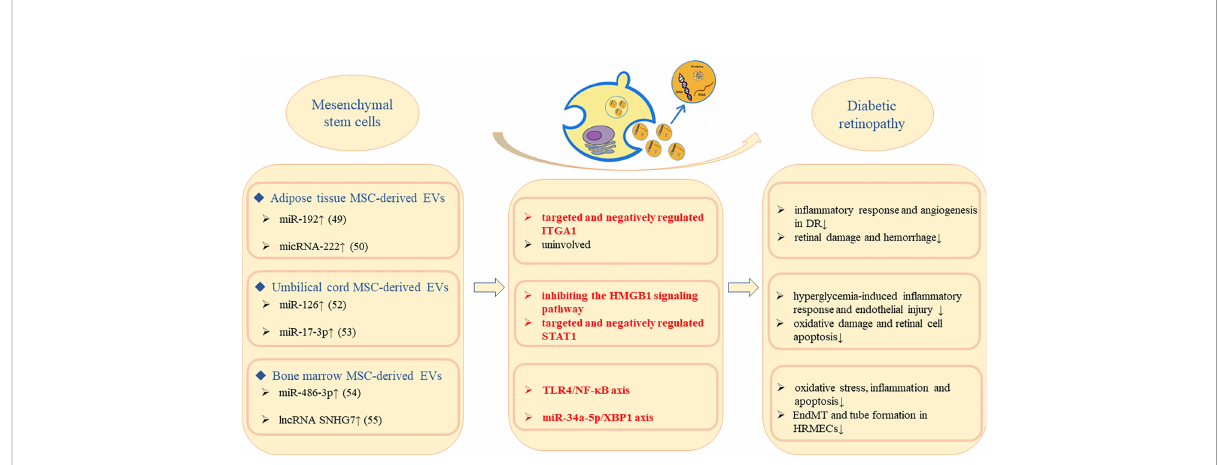
FIGURE 2 Molecular mechanism of MSC-derived EVs to alleviate DR